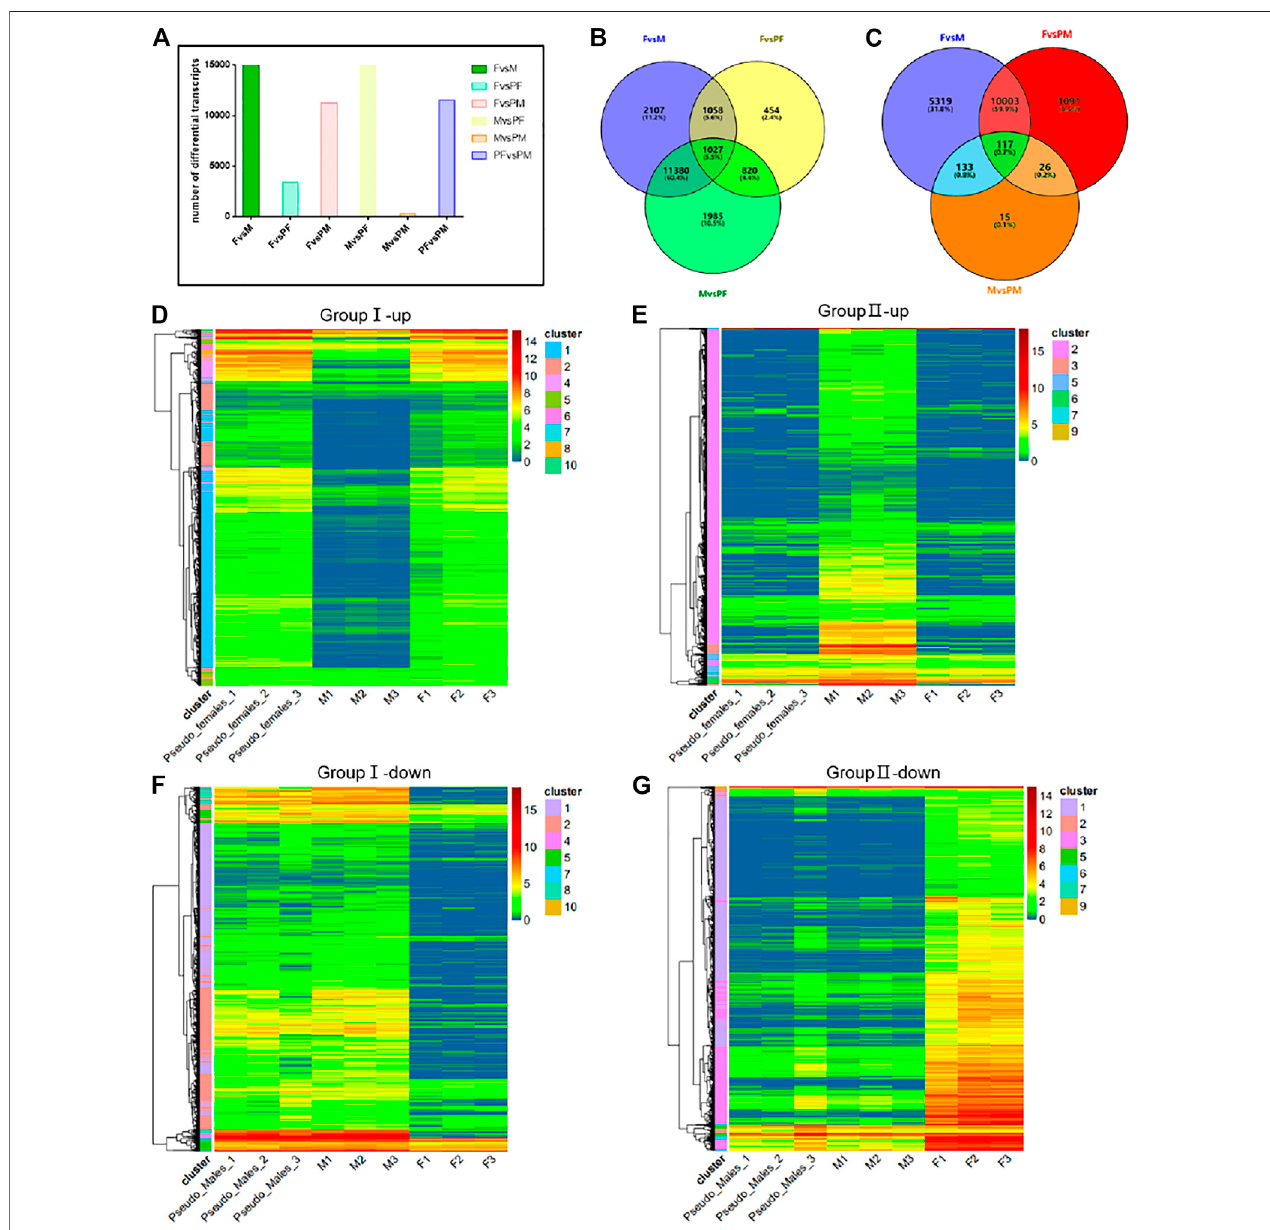
FIGURE 3 | Differential gene expression analysis between gender types. (A) The number of differential transcripts in pairs. (B) The Wayne analysis of differential genes among females, males and pseudo-females. (C) The Wayne analysis of differential genes among females, males and pseudo-males. (D) The cluster analysis of differential up-regulated genes of group I (i.e., F, M, and PF). (E) The cluster analysis of differential up-regulated genes of group II (i.e., F, M, and PM). (F) The cluster analysis of differential down-regulated genes of group I (i.e., F, M, and PF). (G) The cluster analysis of differential down-regulated genes of group II (i.e., F, M, and